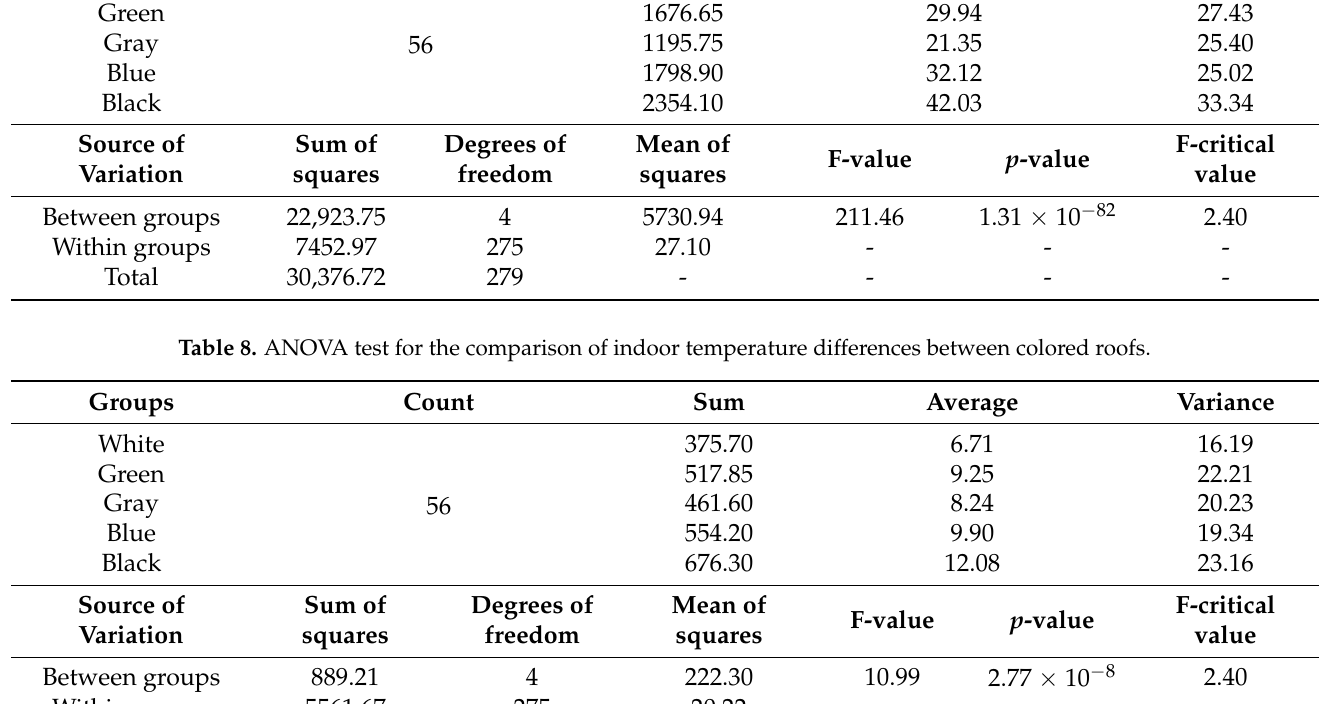
- The average surface temperatures for each colored roof were: 15.85 ◦ C for white, 29.94 ◦ C for green, 21.35 ◦ C for gray, 32.12 ◦ C for blue, and 42.04 ◦ C for black. The average indoor temperature was 6.71 ◦ C for white, 9.25 ◦ C for green, 8.24 ◦ C for gray, 9.90 ◦ C for blue, and 12.08 ◦ C for black. In all the dates and time zones, the black-colored roof was observed to have the highest temperature, and the white-colored roof was observed to have the lowest temperature. As in previous studies, depending on the roof color and its closeness to white, the lower the temperature, and the closer it is to black, the higher the temperature [14]. Light gray was used to express the color of cement in the early stages of construction and showed a tendency toward low temperatures similar to white. In blue and green-colored roofs, a high temperature was recorded, identical to the black-colored roof. If a good maintenance culture is not observed after construction, the color may change to dark gray or black, approaching the black-colored roof temperature value. Conversely, as the color fades over time, blue and green colors may change to white-like colors. In Figure 8, the differences between the black-colored roof temperatures and the others, which were observed to be effective on the warm roof instead of the existing cool roof, were compared. An ANOVA test was also conducted on the temperature differences, and as a result, the p -values of the surface and indoor temperatures were 1.66 × 10 − 8 and 9.25 × 10 − 4 . It can be seen that there is also a statistically significant difference in the temperature differences between the black-colored roof and other colored roofs. The black-colored roof, which was hypothesized to be the most effective in the warm roof phenomenon, was found to have the highest surface and indoor temperatures. For the surface temperature, the black-colored roof appeared to be 8–28 ◦ C higher than other colors, and for the indoor temperature, it was about 1–7 ◦ C higher. Comparing the surface temperatures, the difference between the white-colored roof, reported to be effective in the existing cool roof phenomenon, and the black-colored roof, observed in this study to be effective in the warm roof